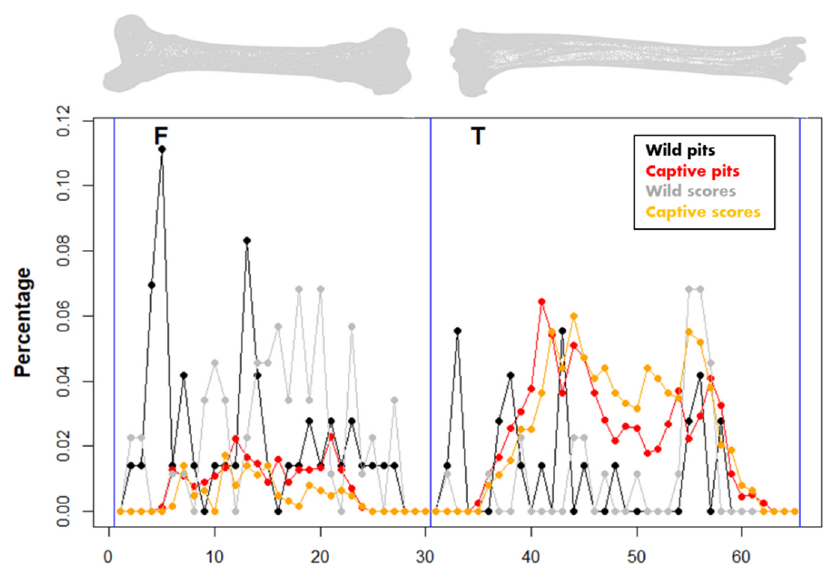
Figure 9. Average relative distribution of tooth marks obtained, including pits and scores, in the wild and captive wolf samples. The x-axis shows the longitudinal dimensions of the series of the left and right femur ( F ) and the tibia ( T ) from the proximal to the distal epiphysis sequentially.